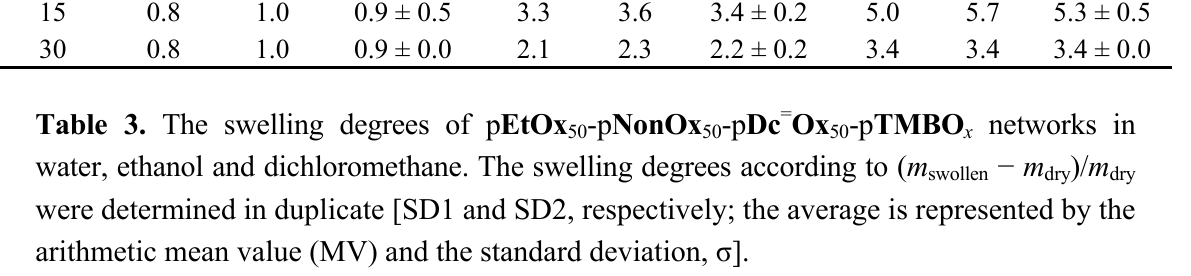
-p NonOx -p Dc = Ox -p TMBO networks in 50 50 50 x − m )/ m swollen dry dry